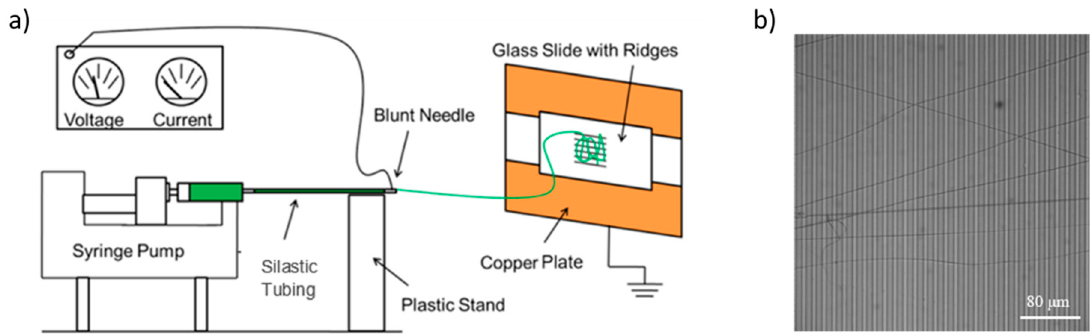
Figure 1. ( a ) Schematic of the electrospinning setup. The electric potential difference between the of electrospun fibers on the striated substrate. Ridges (width, 7.3 µ m; height, 6 µ m) appear in darker needle and the collection site is set to 20,000 V. Figure adapted from [3]. ( b ) Optical microscopy image gray; gaps (6 µ m across) appear in lighter of electrospun fibers on the striated substrate. Ridges (width, 7.3 μ m; height, 6 μ m) appear in darker gray; gaps (6 μ m across) appear in lighter gray.